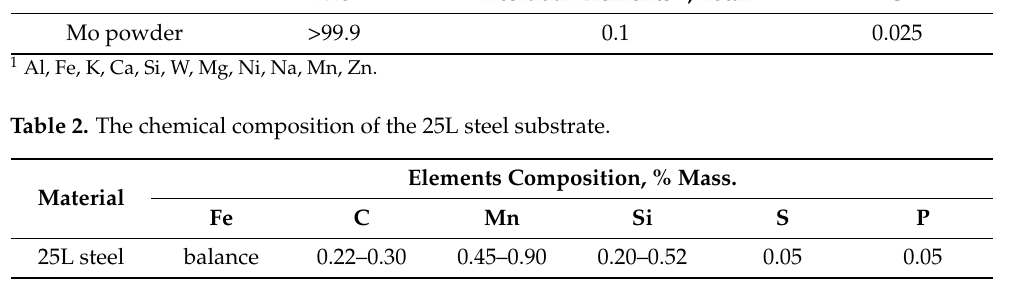
Figure 1. An assembly of the ‘body’ part: a—molybdenum plate, b—copper brazing alloy, c—25L steel base. Table 1. The chemical composition of the Mo powder PMS-M99,9 [35]. Elements Composition, % Mass. Material Mo